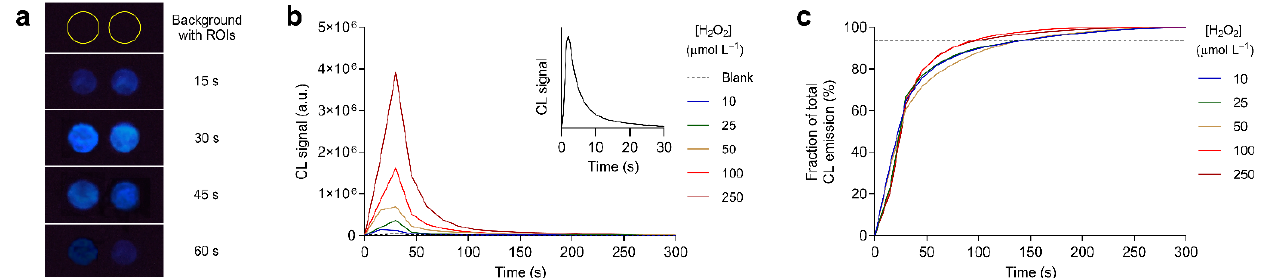
Figure 4. ( a ) Background correction image and first CL images acquired during an assay. The ROIs used for quantification of the CL signal are shown in the background correction image; ( b ) kinetic profiles of the CL signals obtained in the origami µPAD for different concentrations of hydrogen peroxide (time zero corresponds to the addition of the carbonate transport buffer). The inset shows the kinetic profile of the CL signal observed in solution after mixing luminol, potassium hexacyanoferrate(III), and hydrogen peroxide; ( c ) fraction of the total CL emission as a function of the time elapsed since the delivery of the carbonate transport buffer for different concentrations of hydrogen peroxide. The dashed line corresponds to 95% of the total CL emission.